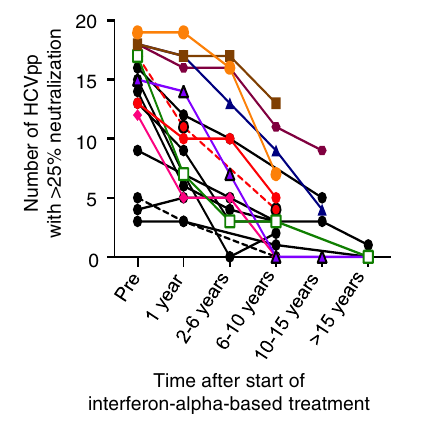
duplicate, is indicated for each HCVpp. b , c Dynamic change in the neutralization breadth at serial time points prior to (pre) and after interferon-induced HCV clearance. b Number of HCVpp that were neutralized at >25% by the sera in ( a ). c Average number of HCVpp neutralized with the indicated neutralization ef fi cacy by the sera in ( a ). Source data are provided as a Source Data fi